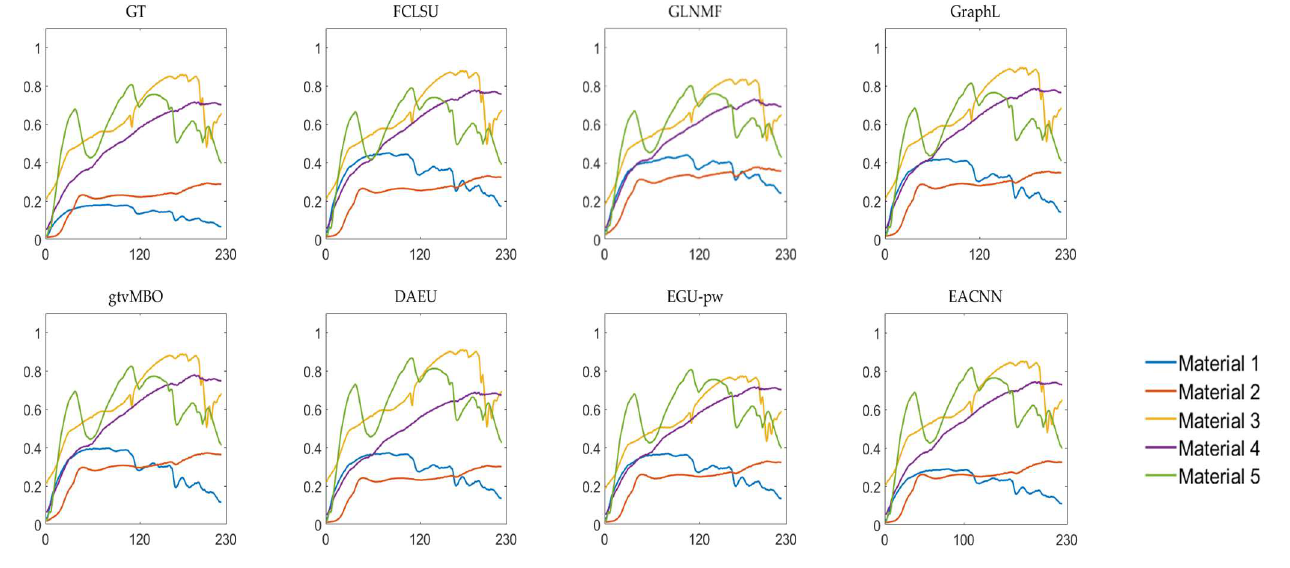
Figure 3. The endmember extraction results for the synthetic data.